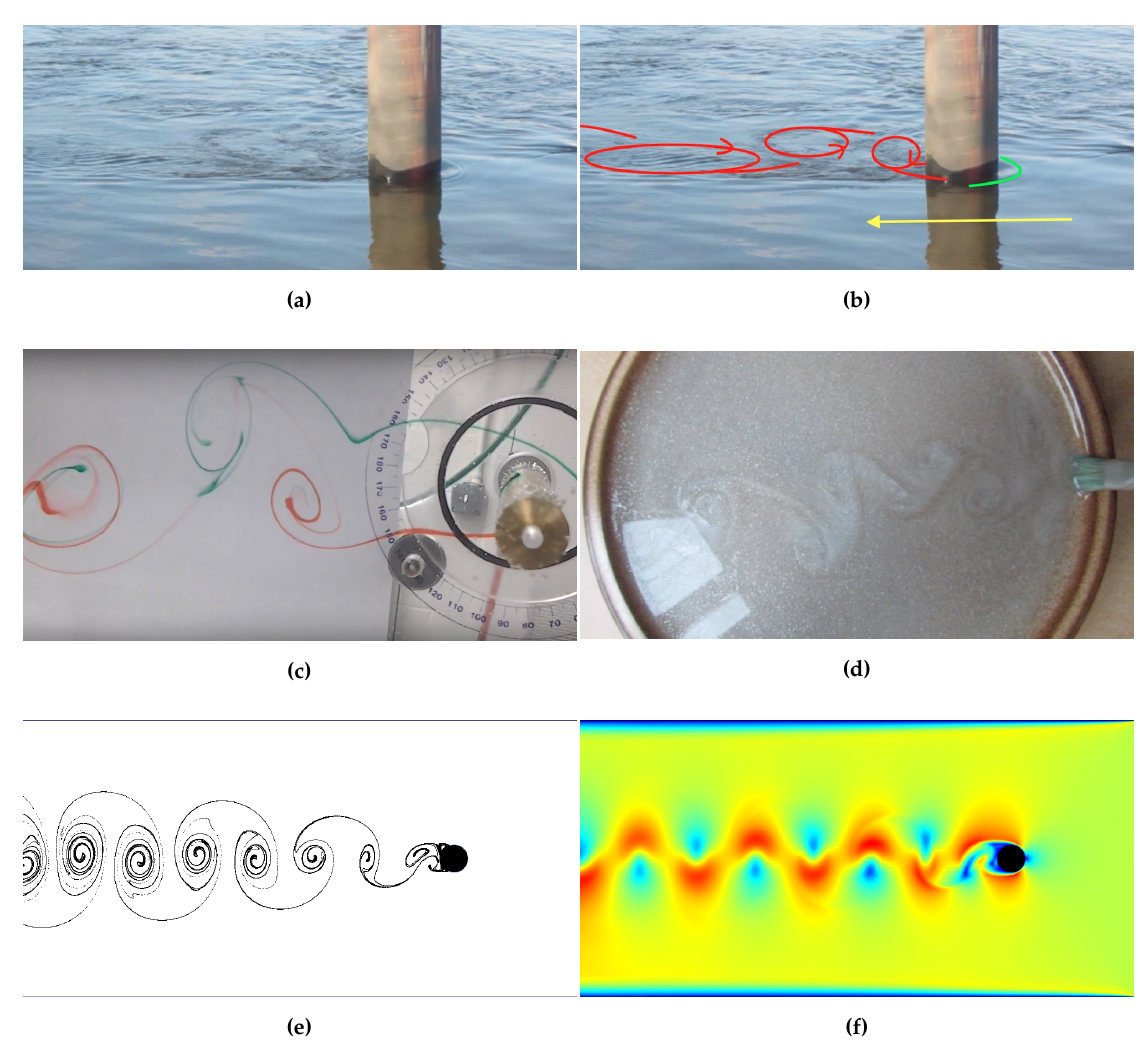
Figure 1. Comparison of a fluid mechanics problem, a Kármán vortex street, in situ, in two different laboratory realizations and in an ELBE simulation. ( a ) Periodically shedding, alternating eddies downstream of a cylinder in the Elbe river. ( b ) Same as (a), but the direction of flow (yellow) and the structures of eddies (red) are indicated. ( c ) Vortex shedding behind a cylinder in a water tunnel. The flow field is visualized using food coloring diluted in water. Picture by courtesy of Sarwesh Narayan Parbat. ( d ) “Kitchen experiment” of the same situation as in the other figures. A paint brush is moved through sugar water dyed with metallic water colors to simulate the above situation. ( e , f ) ELBE simulation results of a similar situation: ( e ) adding “dye” yields a visualization similar to the water tunnel; ( f ) velocity